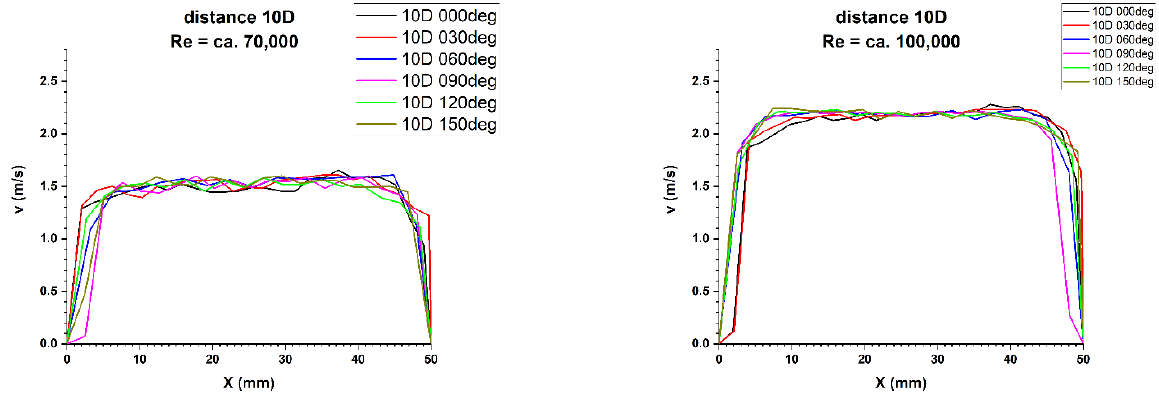
Figure 19. Comparison of velocity profiles at a distance 8D from the disturbance with marked cross-sections for Re ≅ 70,000 and 100,000-The LDA measurement taken in the ultrasound wave path.